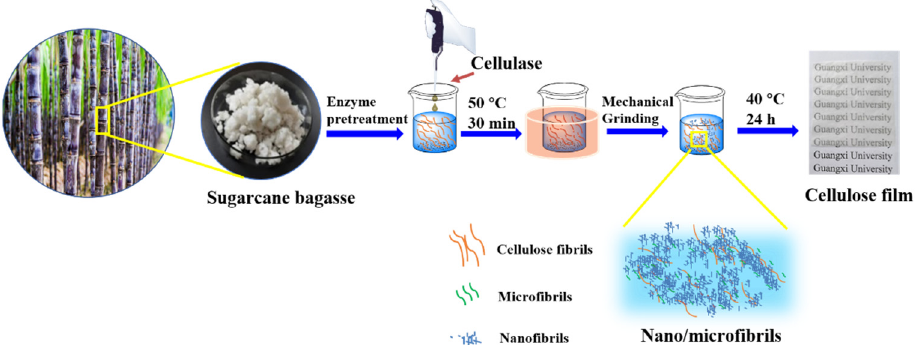
Figure 1. Schematic representation of process for preparing nano/microfibril film.